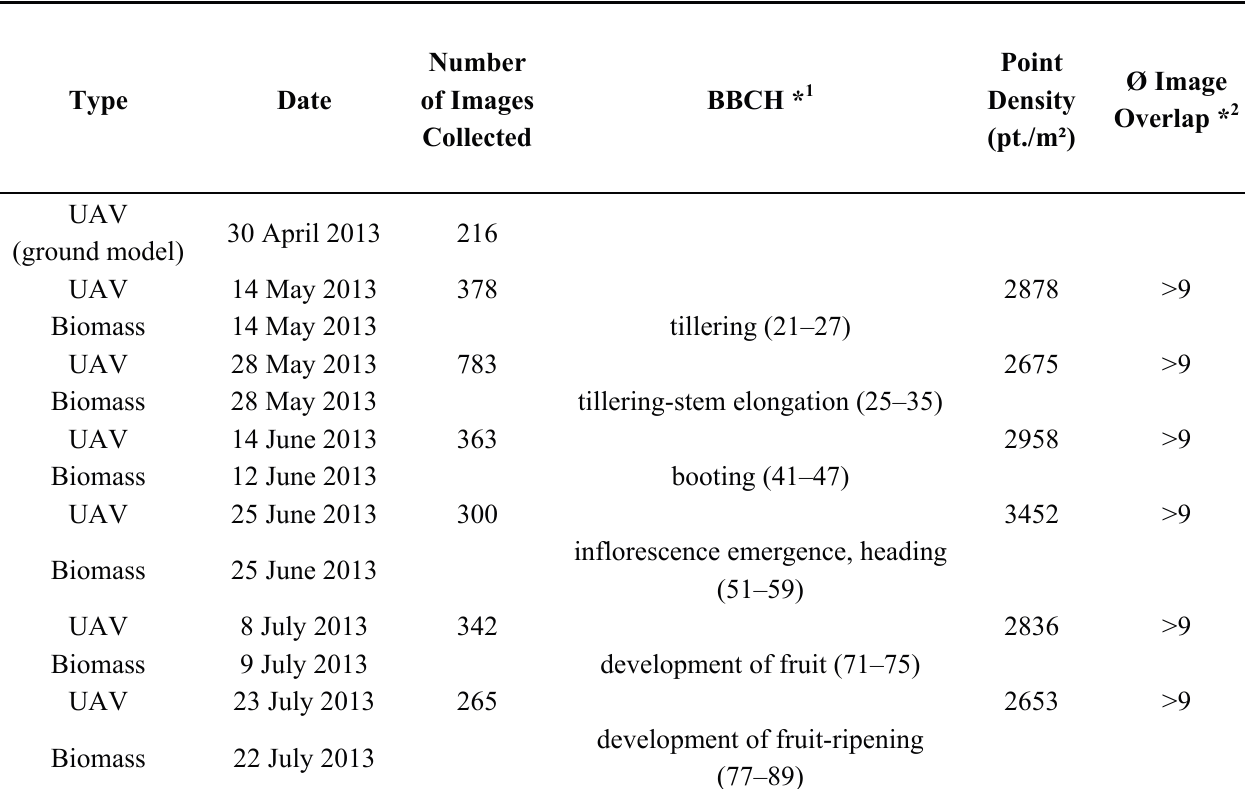
Table 1. Details of unmanned aerial vehicle (UAV) flight campaigns (CSM resolution 0.01 m) and destructive biomass